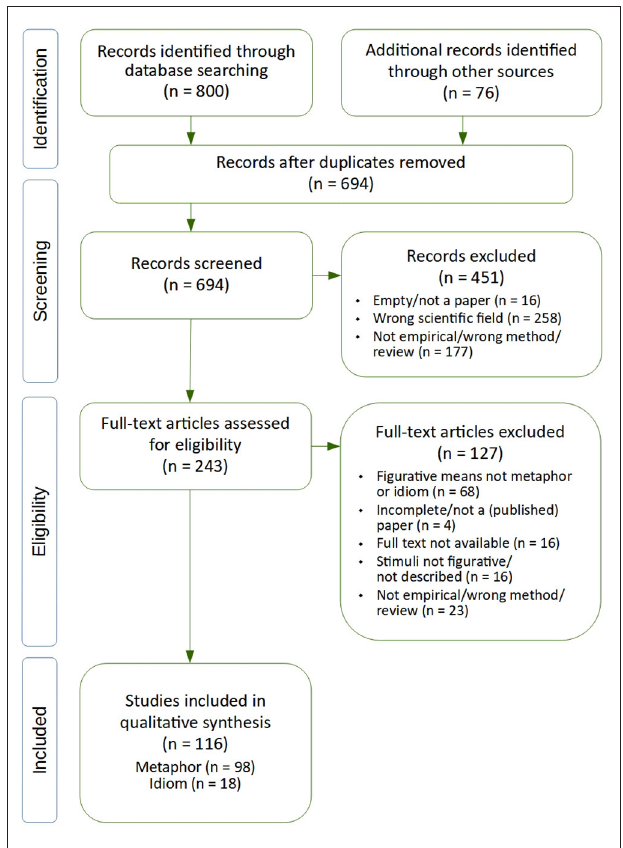
FIGURE 1 | The literature synthesis process. Graphics template by Moher et al. (2009).